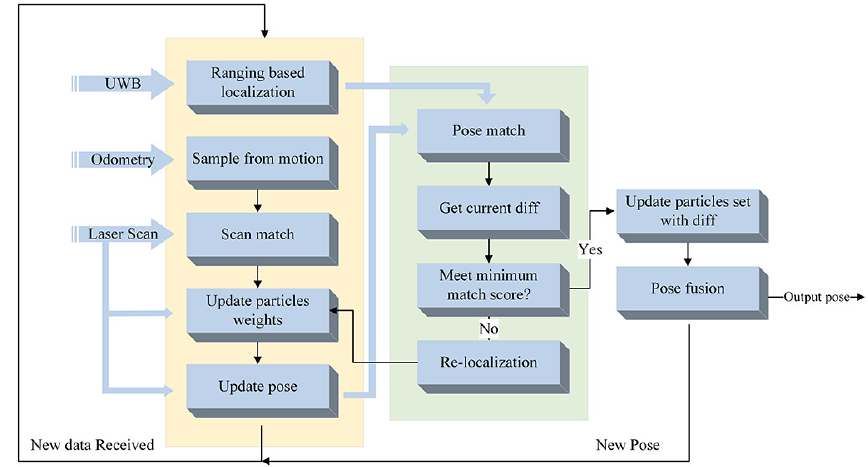
Figure 1. Framewrok of UAPF proposed in this